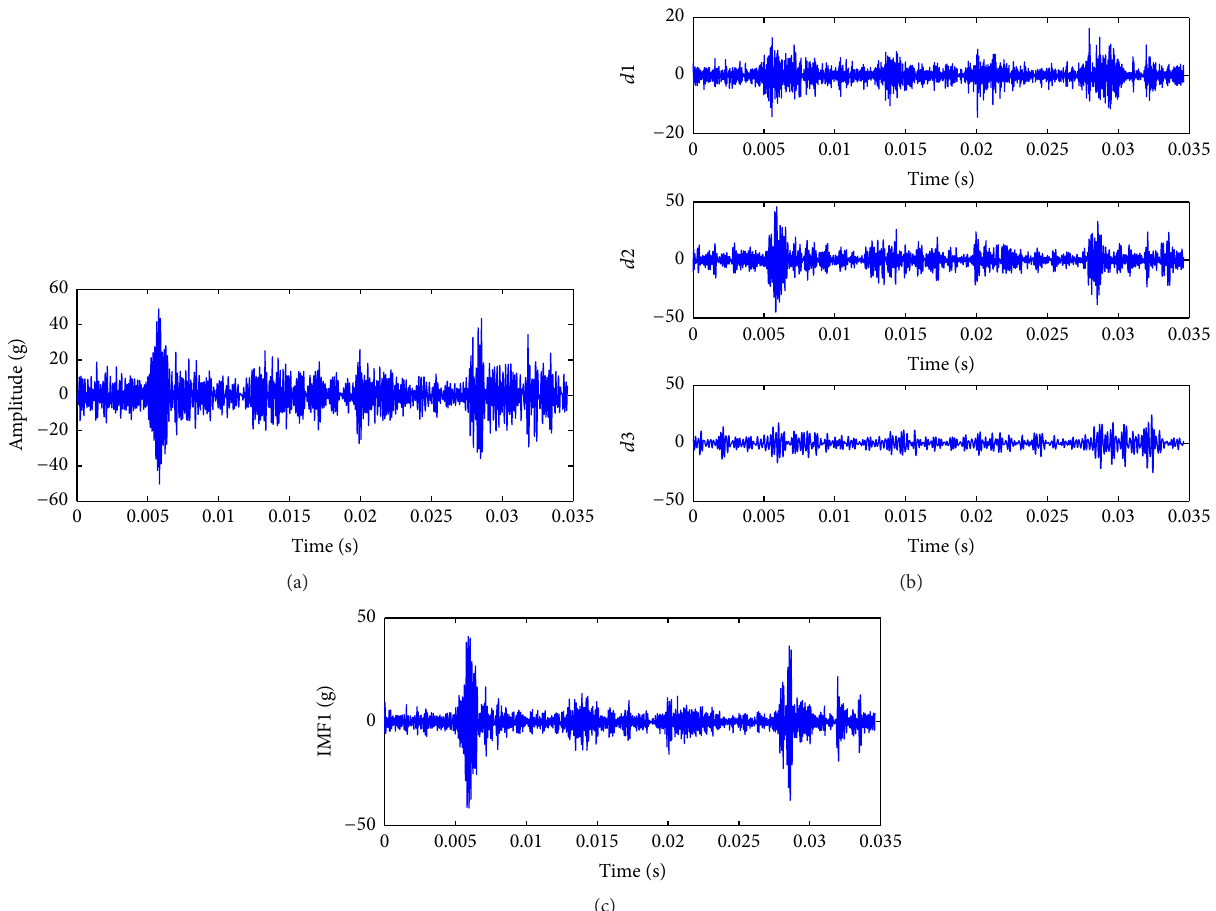
Figure 11: (a) The filter result of cylinder block vibration signal. (b) The DWT result of cylinder block vibration signal. (c) The IMF1 of CEEMD result of cylinder block vibration